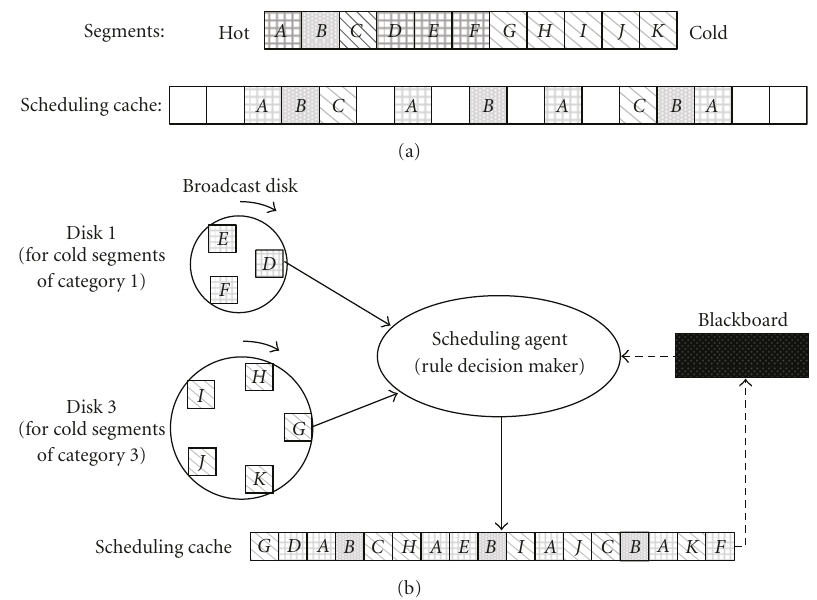
Figure 4: The scheduling model: (a) for hot segments; (b) for cold